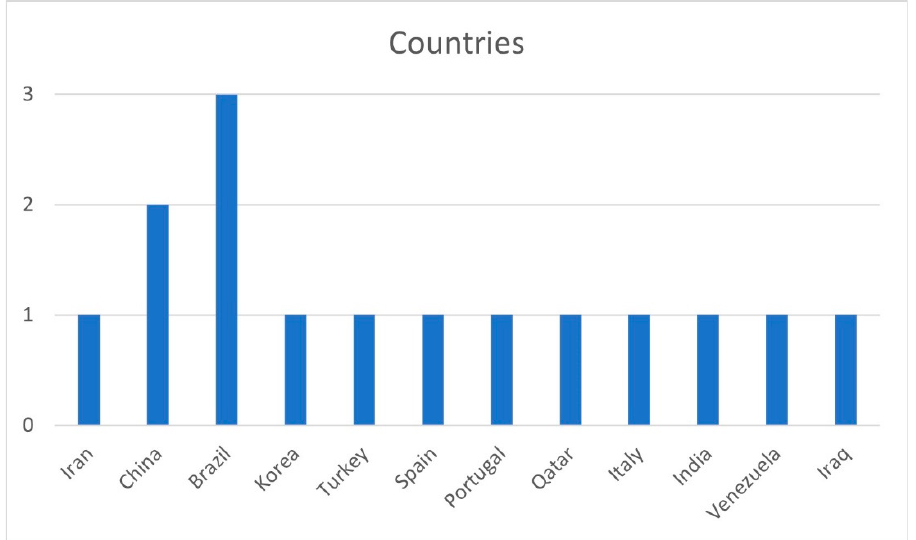
Figure 4. Distribution by country of publication.